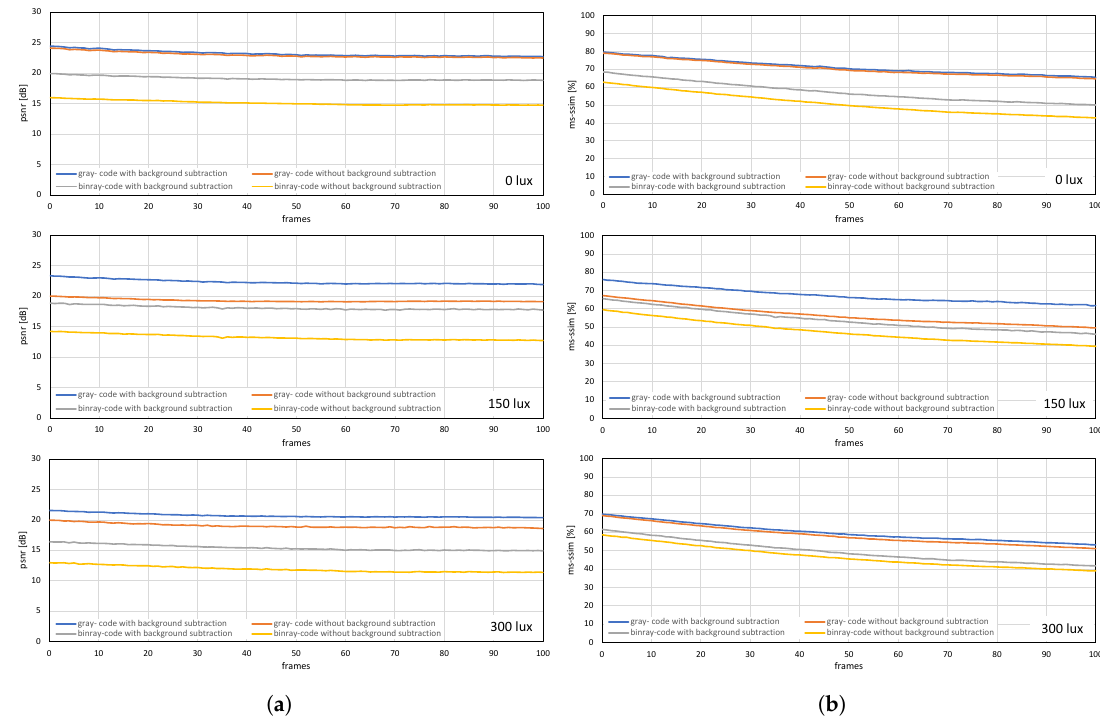
Figure 12. ( a ) PSNRs and ( b ) MS-SSIMs when a stored video sequence is streamed with pure-binary-code and gray-code images on a plain background.